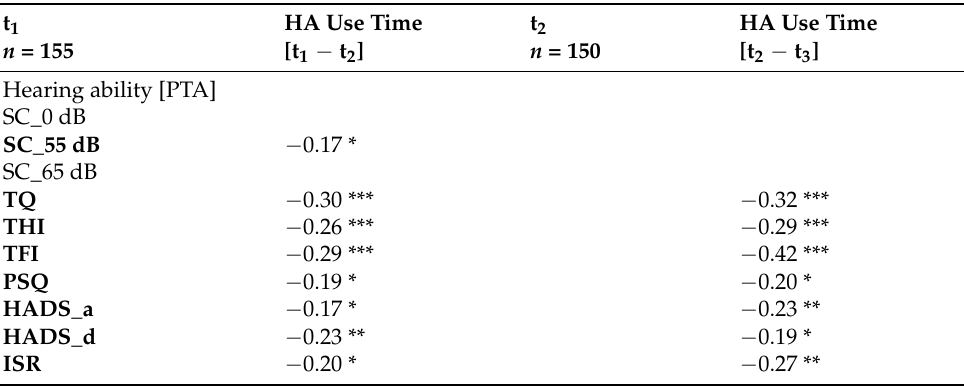
Table 2. Significant correlation coefficients between HA use time (t 1 − t 2 ) and general audiological as well as distress-related indices at pre- and post-treatment. Patients’ hearing ability was measured at a preceding screening timepoint. PTA = pure tone audiometry; SC = speech comprehension; TQ = Tinnitus Questionnaire; THI = Tinnitus Handicap Inventory; TFI = Tinnitus Functional